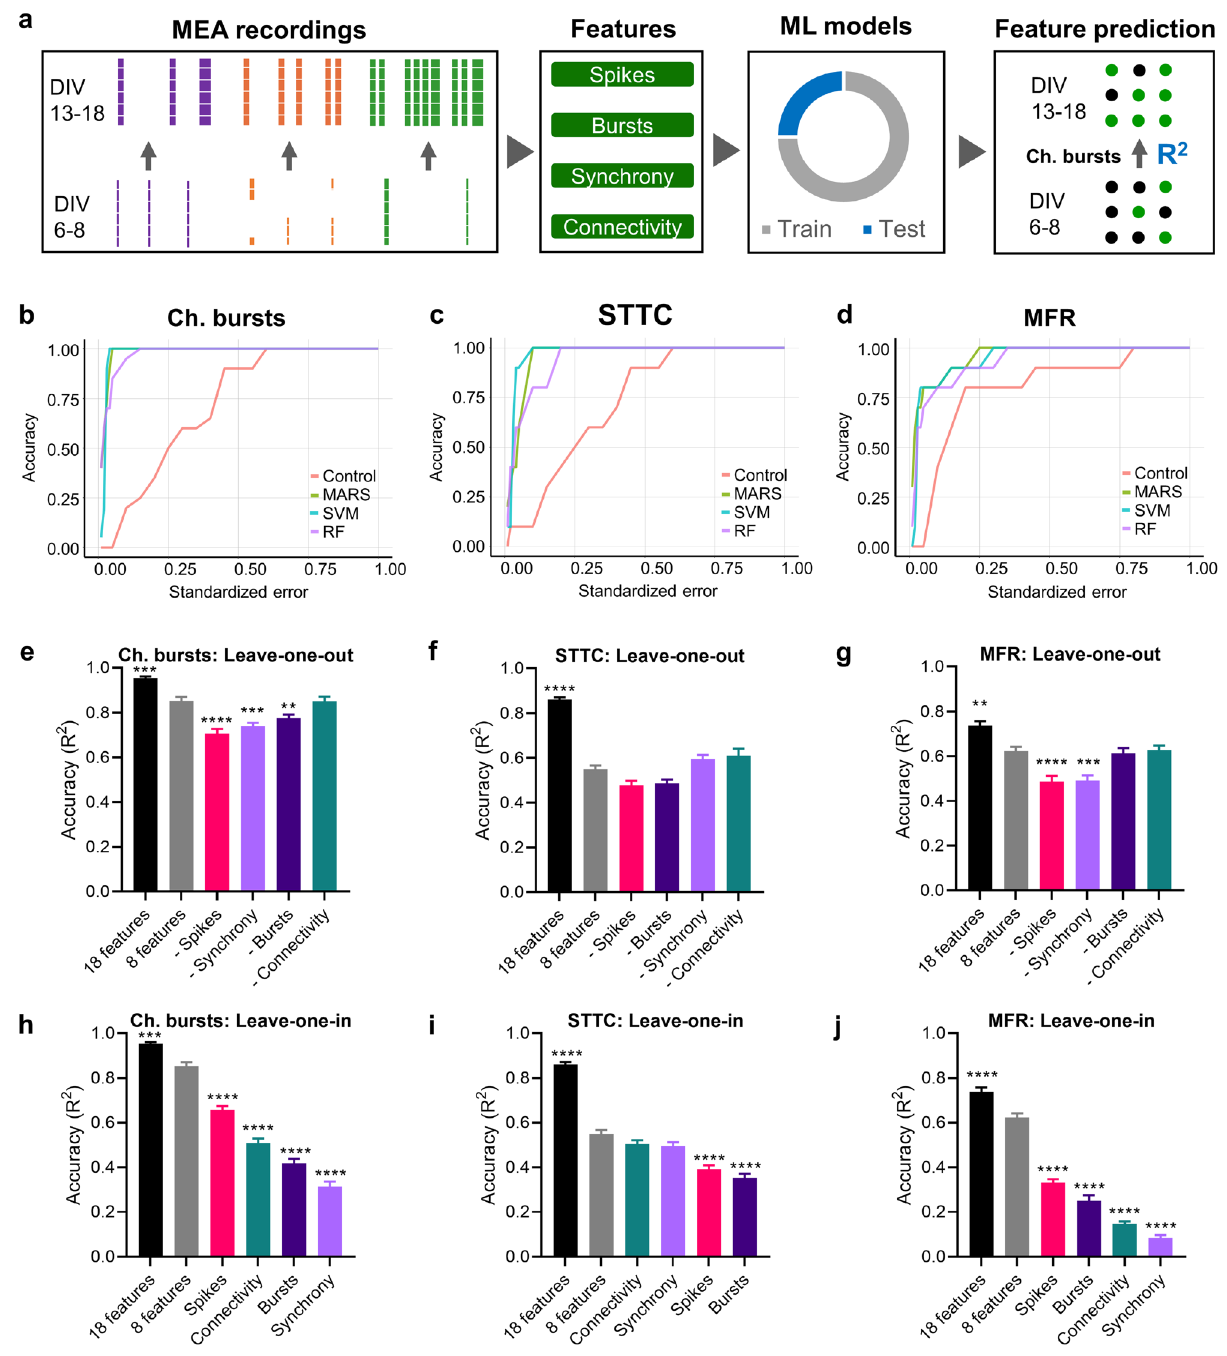
Figure 5. Machine learning for the prediction of features of bursts, synchrony, and spikes. ( a ) Schematics of the machine learning workflow. The 18 electrophysiological features were analyzed from MEA recordings at DIV 6–8 and DIV 13–18 and these features were used to train (gray segment) machine learning (ML) models. Then, accuracy prediction (R 2 ) at DIV 13–18 was evaluated in the test dataset (blue segment) for electrophysiological features (e.g., Ch. bursts). Figure created with Microsoft PowerPoint 365 (https:// www. micro soft. com/ power point). ( b – d ). REC curves for control and MARS, SVM, and Random Forest (RF) machine learning models for the prediction of STTC ( b ), Ch. bursts ( c ), and MFR ( d ). REC curves represent the cumulative error obtained by the machine learning models. ( e-j ) SVM prediction of Ch. bursts ( e – h ), STTC ( f – i ), and MFR ( g – j ) using leave-one-out ( e – g ) and leave-one-in ( h – j ) strategies. We performed fourfold cross-validation (10 iterations) to calculate the mean accuracy of the SVM prediction using 8 electrophysiological features (2 features per group): MFR and Ch. spikes (spikes), MBR and Ch. bursts (bursts), STTC and DBSCAN STTC (synchrony), and Efficiency and Clustering coeff (connectivity). Feature importance was evaluated by removing (leave-one-out) or leaving (leave-one-in) one group of features. Baseline accuracy of cross-validation was calculated using the 18 features. Error bars represent the mean ± SEM. * P < 0.05, ** P < 0.01, *** P < 0.001, **** P < 0.0001 vs accuracy obtained with 8 features (one-way ANOVA, followed by Dunnett’s post hoc multiple comparison test). The figure was created using Microsoft PowerPoint 365 (https:// www. micro soft. com/ power point) ( a ), R 4.03 (https:// www.r- proje ct. org/) ( b ), and Graphpad 8.0 (https:// www. graph pad. com) ( e – j